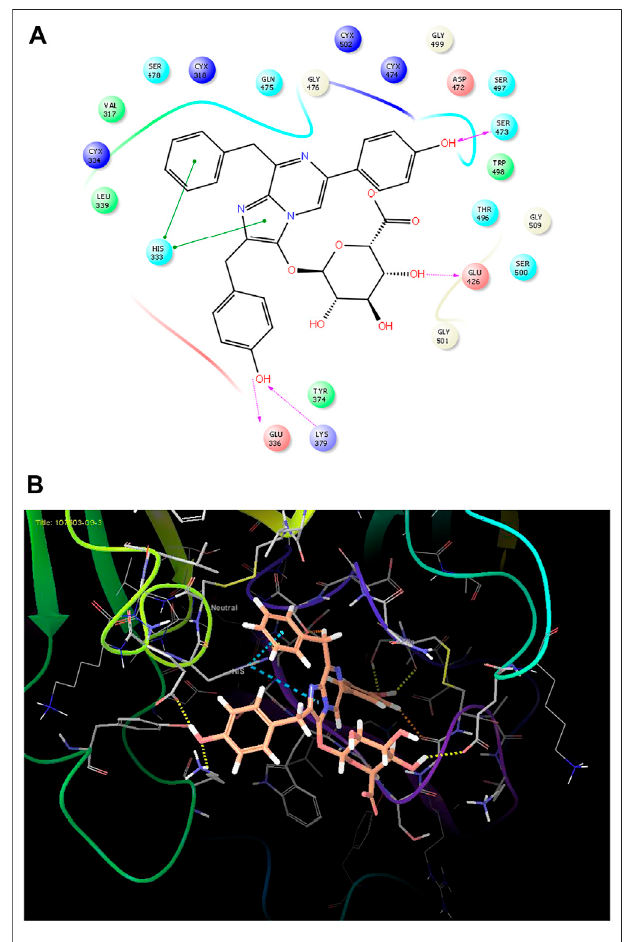
FIGURE 4 | (A) The best pose of docking (2D) of ligand 10 at the predicted catalytic domain of TMPRSS2. (B) The 3D presentation of the best docking pose of ligand